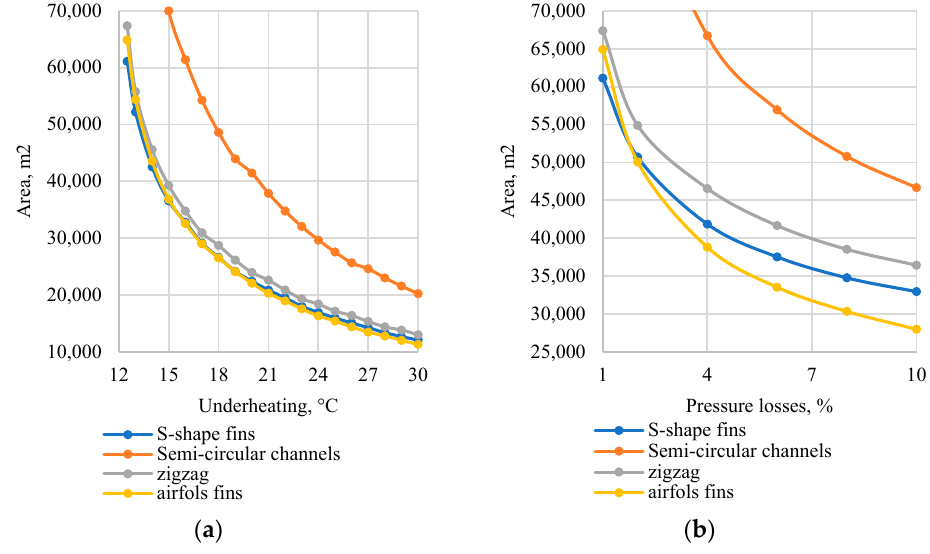
Figure 9. Dependence of heat transfer area from: ( a ) underheating, ( b ) regenerator pressure losses. Increase of the heat carrier flow velocity may be a method for the dimensions